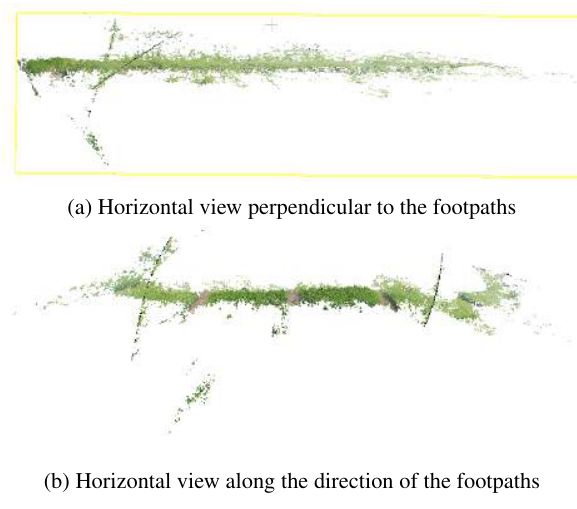
Figure 3. Two views of the whole point cloud for the morning of June 4 generated by SURE